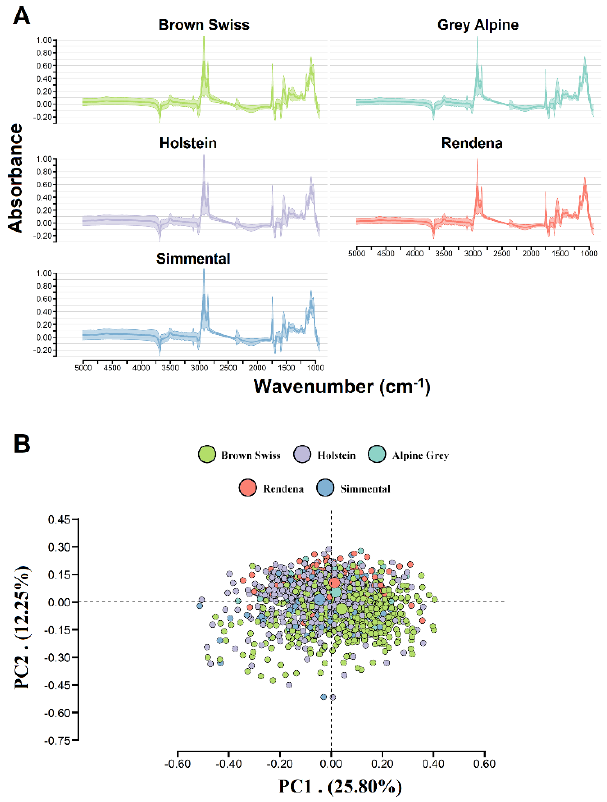
Figure 1. ( A ) Average value for Fourier-transform infrared (FTIR) spectra absorbance across spe- cialized and dual-purpose breeds (solid line represents the average and color region represents the mean ± 3.5 × SD) and ( B ) principal component (PC) for the FTIR spectral data of milk samples recorded on specialized dairy breeds (Holstein and Brown Swiss) and dual-purpose breeds (Simmen- tal, Alpine Grey, and Rendena). The big dot represents the PC means, and Holstein and Simmental breeds are overlapping the